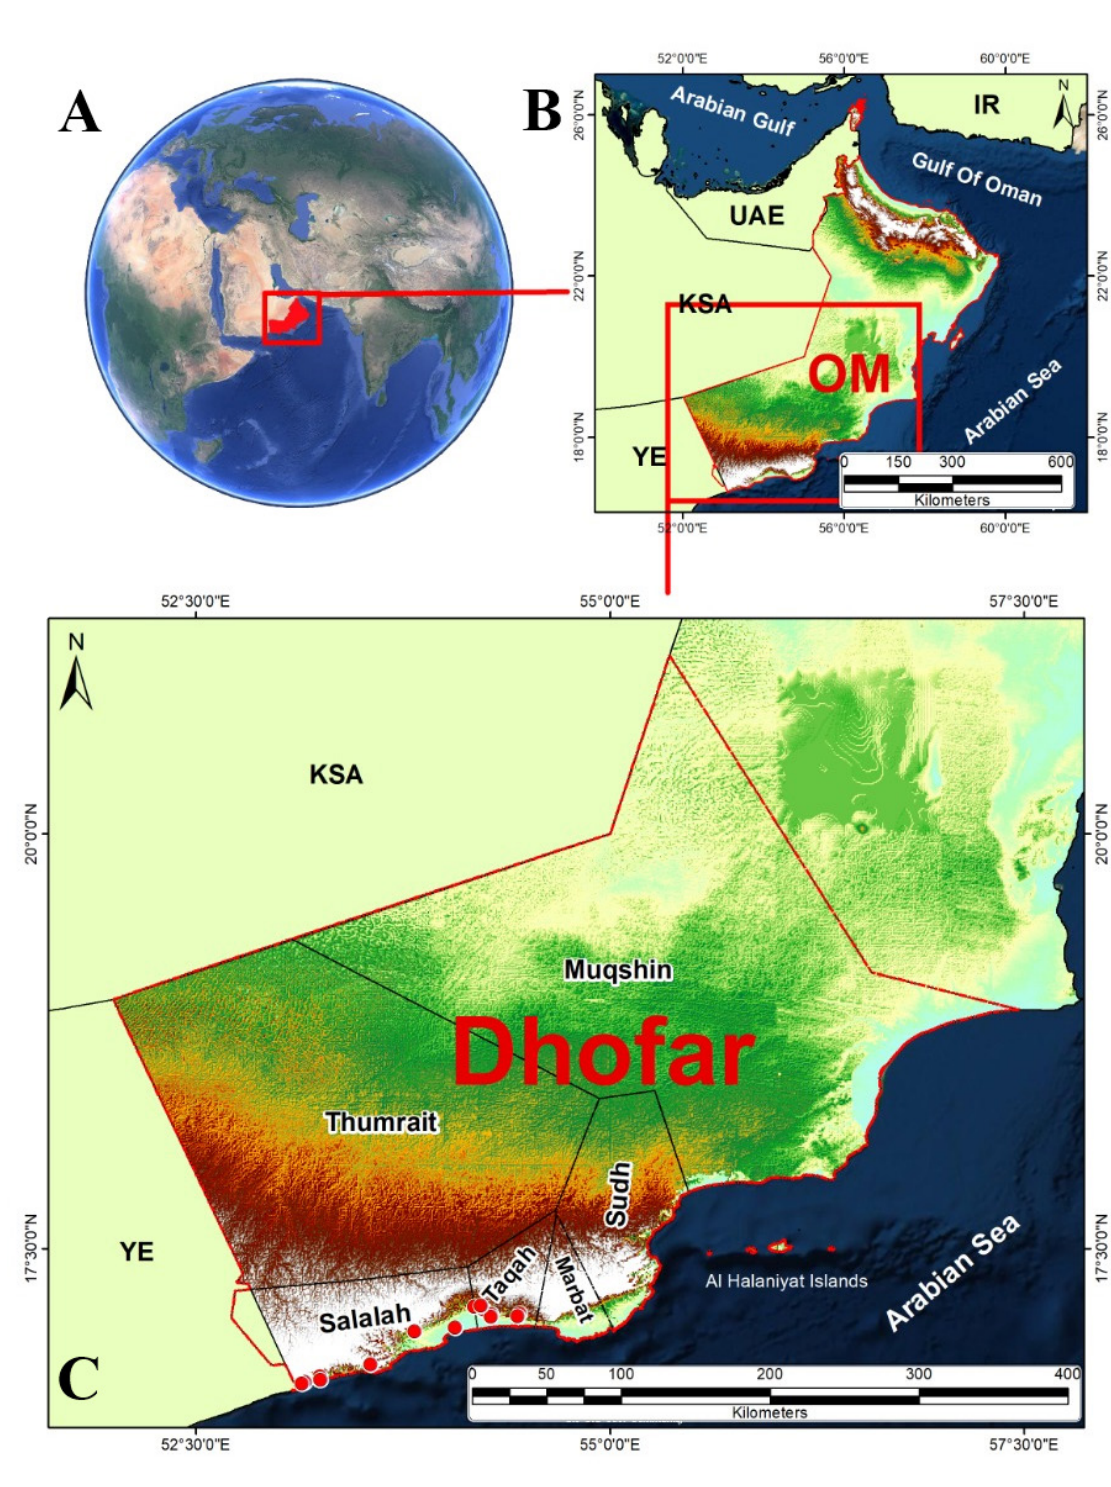
Fig. 1. A–B . Oman and adjacent continental land masses. C . Dhofar